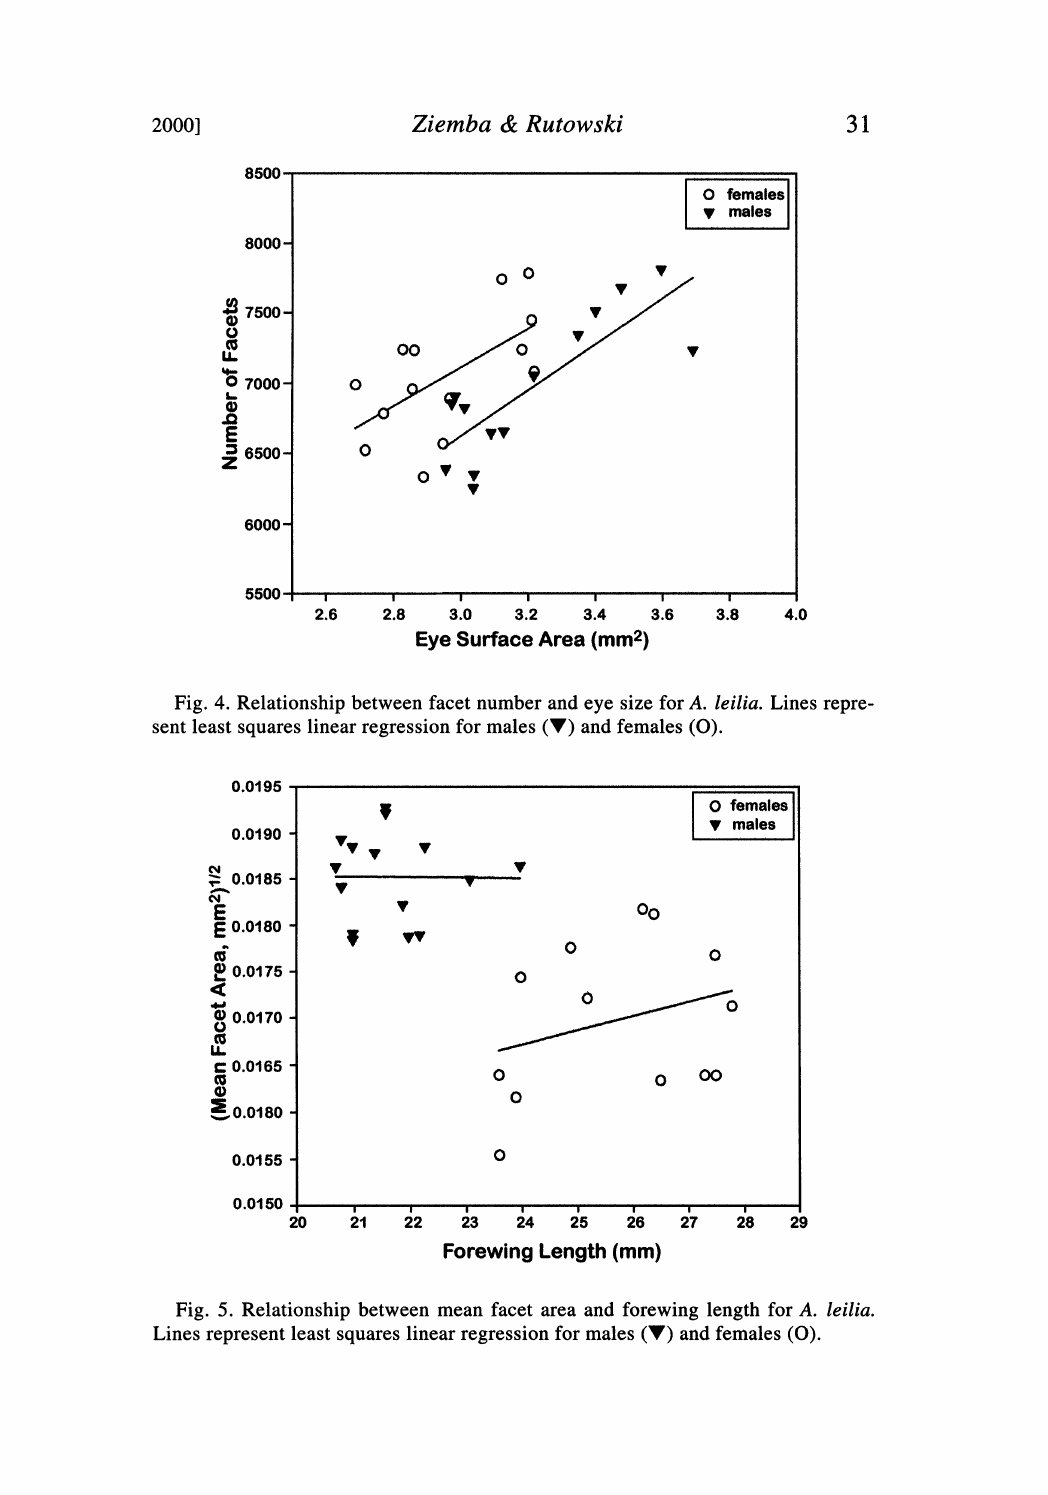
Fig. 5. Relationship between mean facet area and forewing length for A. leilia. Lines represent least squares linear regression for males (’) and females